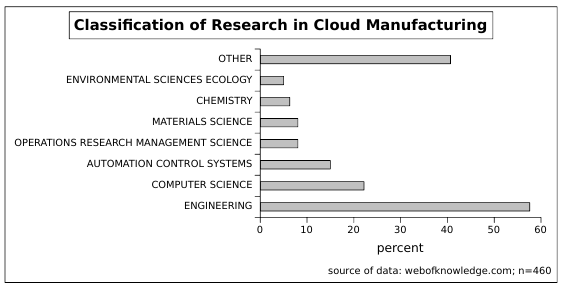
Figure 2. Classification of articles for Cloud Manufacturing; source of data: webofknowledge.com.